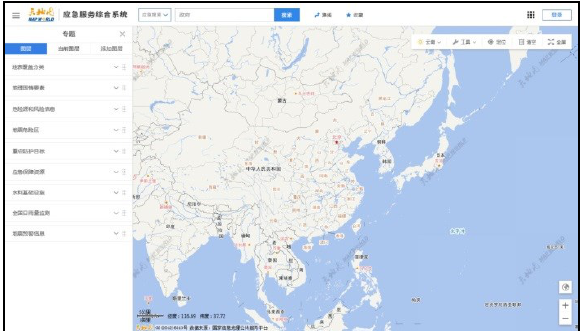
Figure 1 ． Disaster early warning and emergency rescue comprehensive service system